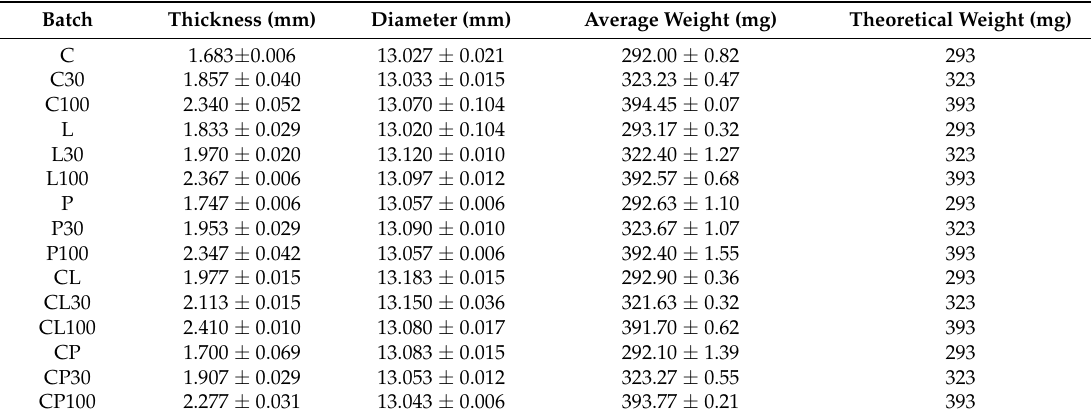
Table 3. Data of thickness (mm), diameter (mm) and weight (mg) of the tablets prepared.